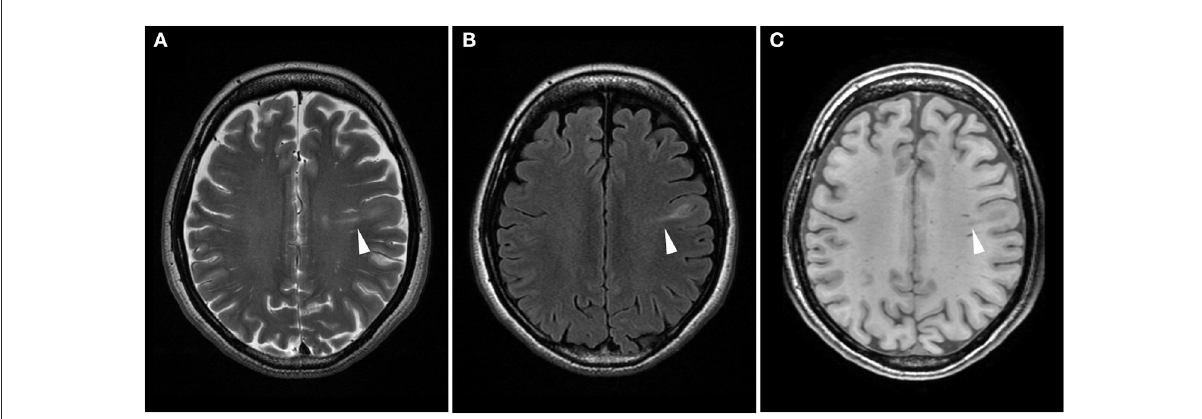
FIGURE1 Difference in the signal intensity of a transmantle lesion across magnetic resonance imaging sequences. Axial T2-weighted (A) and fluid attenuated inversion recovery (B) images show high-intensity areas, while spoiled gradient recalled echo image (C) reveals low-intensity areas